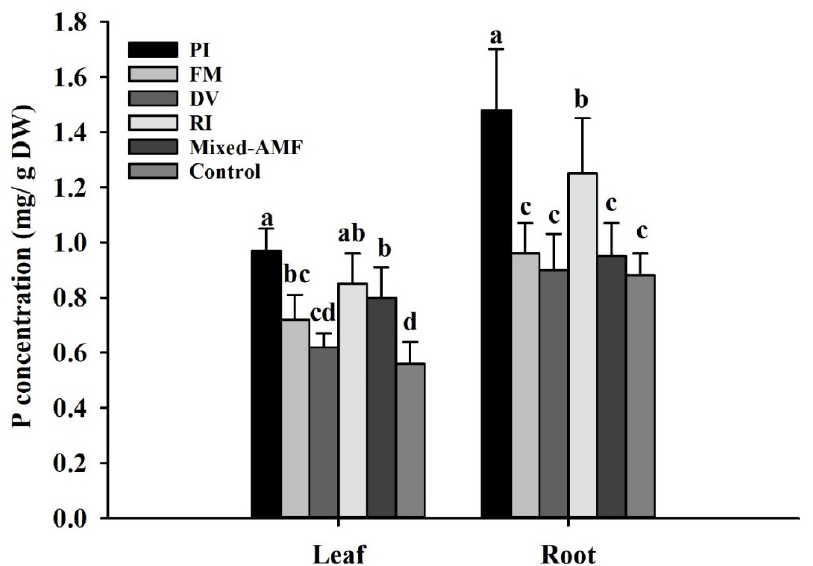
Figure 5. Effects of symbiotic fungi on leaf and root P concentrations of Camellia oleifera plants. Data (means ± SD, n = 6) followed by different letters above the bars indicate significant ( p < 0.05) differences. The abbreviation is the same as Table 2.